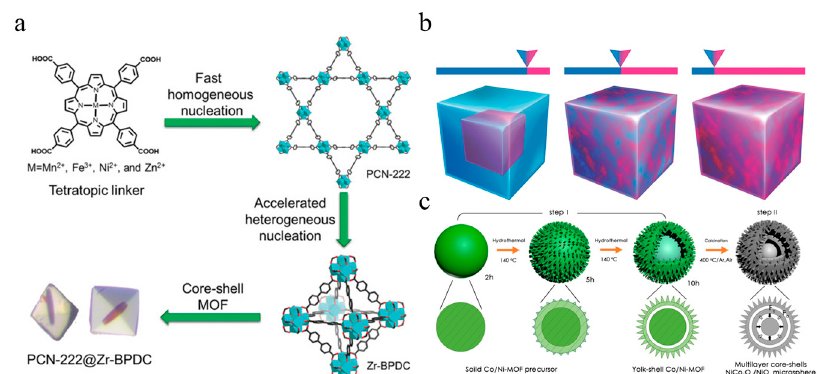
Figure 3. ( a ) Schematic diagram of the one-step synthesis of core-shell metal–organic framework hybrids: PCN-222@Zr-BPDC. Adapted with permission from Ref. [47], 2023, John Wiley and Sons; ( b ) Schematic illustration of Co 20 Zn 80 -ZIF, Co 50 Zn 50 -ZIF, and Co 80 Zn 20 -ZIF. Adapted with permis-